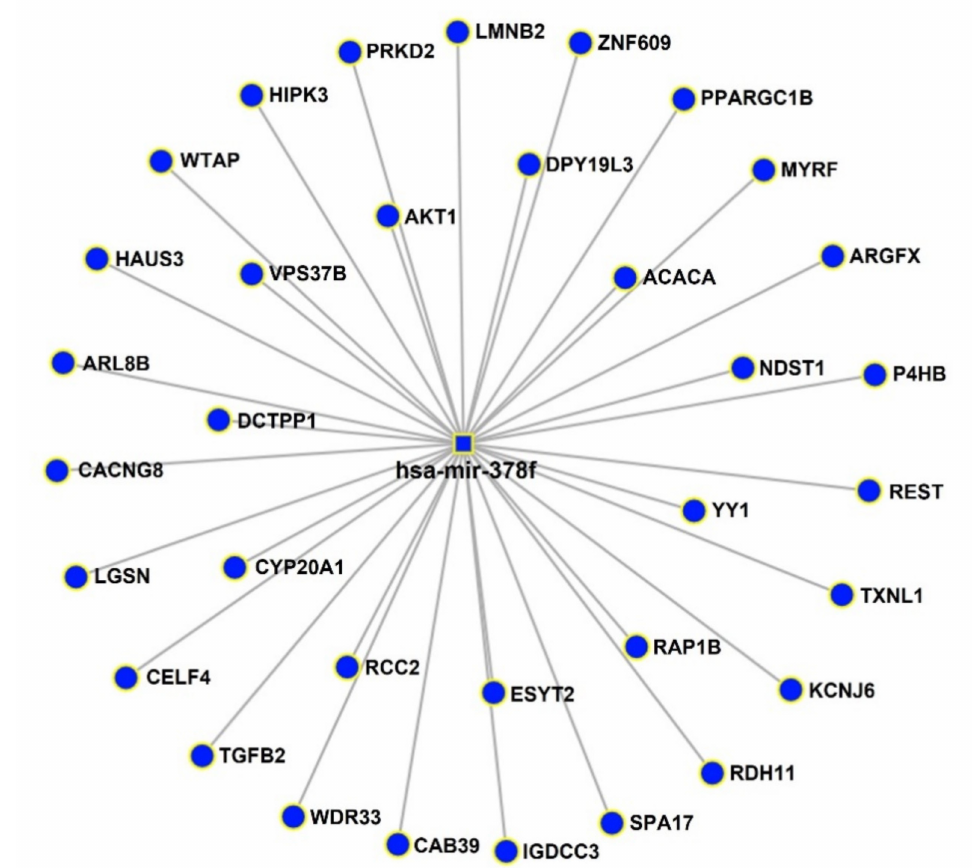
Figure 3. The interaction network of DE miRNA and their experimentally validated target genes. The network was generated using the miRNet